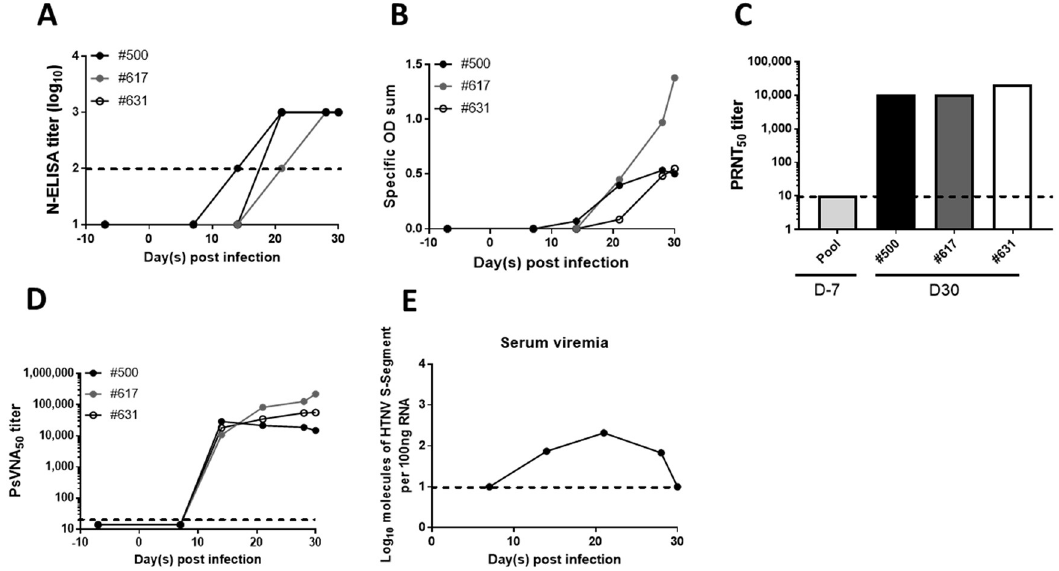
Fig 8. Marmosets are susceptible to HTNV infection. Three marmosets were infected with 1,000 PFU HTNV i.m. Sera was collected weekly to monitor seroconversion. N-ELISA titer (log 10 ) ( A ) N-ELISA specific OD sum ( B ) PRNT 50 ( C ) and PsVNA 50 titers( D ) are displayed. Serum viremia was assayed by RT-PCR ( E ). The limit of detection for N-ELISA titer (2log 10 ), PRNT (20), PsVNA (20) and RT-PCR (1.0log 10 ) is depicted by the dotted